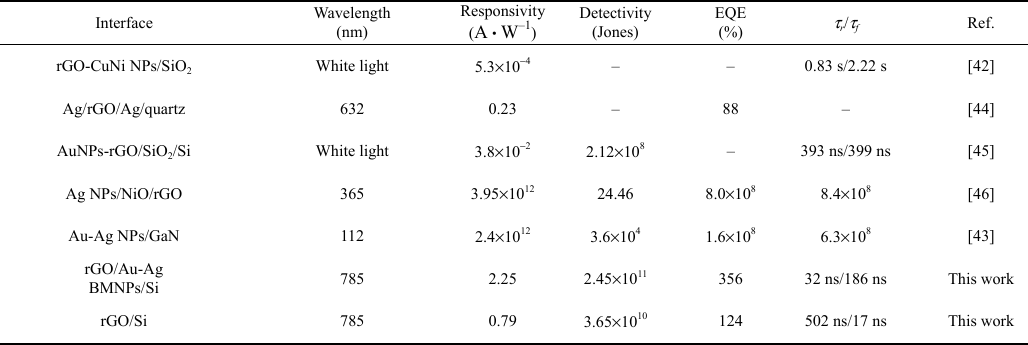
Table 2 Comparison of the performance device between the rGO and bimetallic